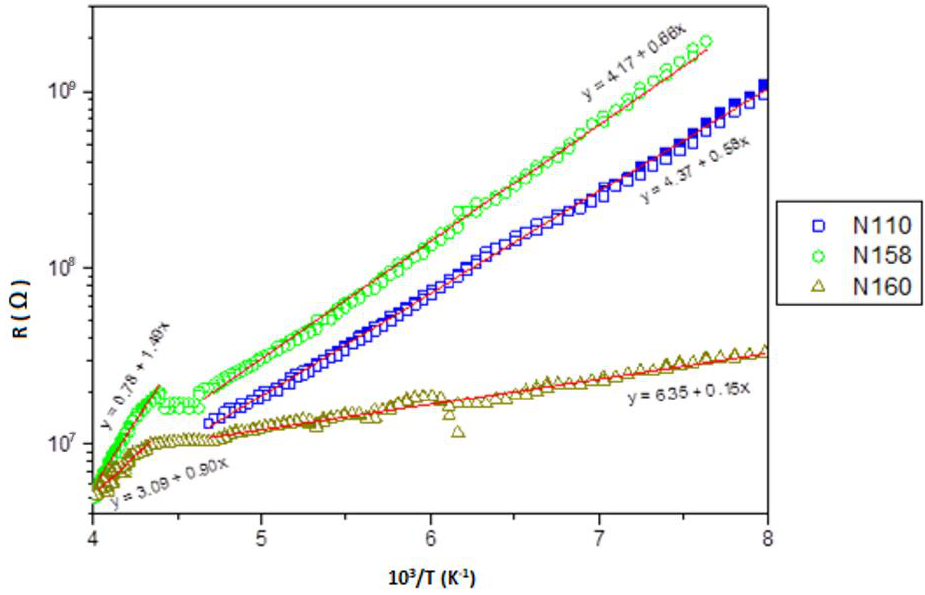
Figure 11. Electrical resistance as a function of the temperature of PbTe (N110), PbTe:In (N158), and PbSe